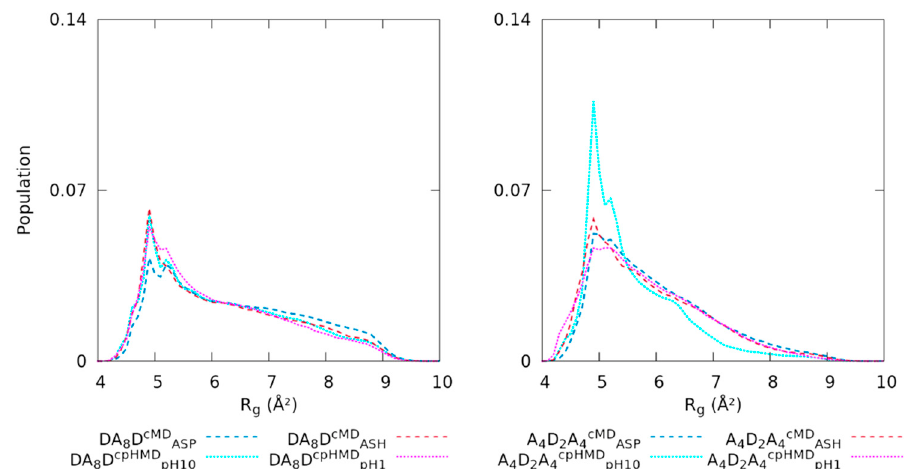
Figure 7. Comparison of the normalized distributions of Rg of the DA 8 D ( left ) and A 4 D 2 A 4 ( right ) peptides. The simulation methods are represented in dashed (cMD) or dotted (cpHMD) lines. Cyan and blue colours indicate the deprotonated form, and magenta and red colours indicate the protonated one.